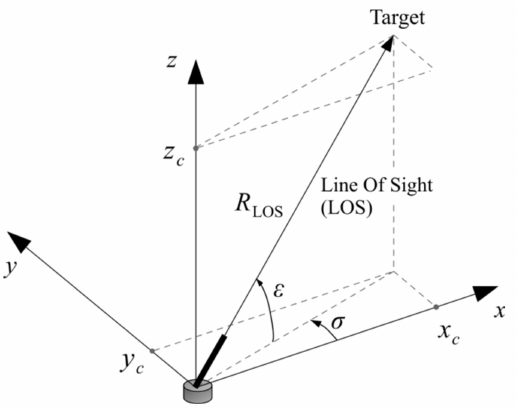
Figure 4. General view of the LOS position defined by angles ε and σ in the earth’s coordinate